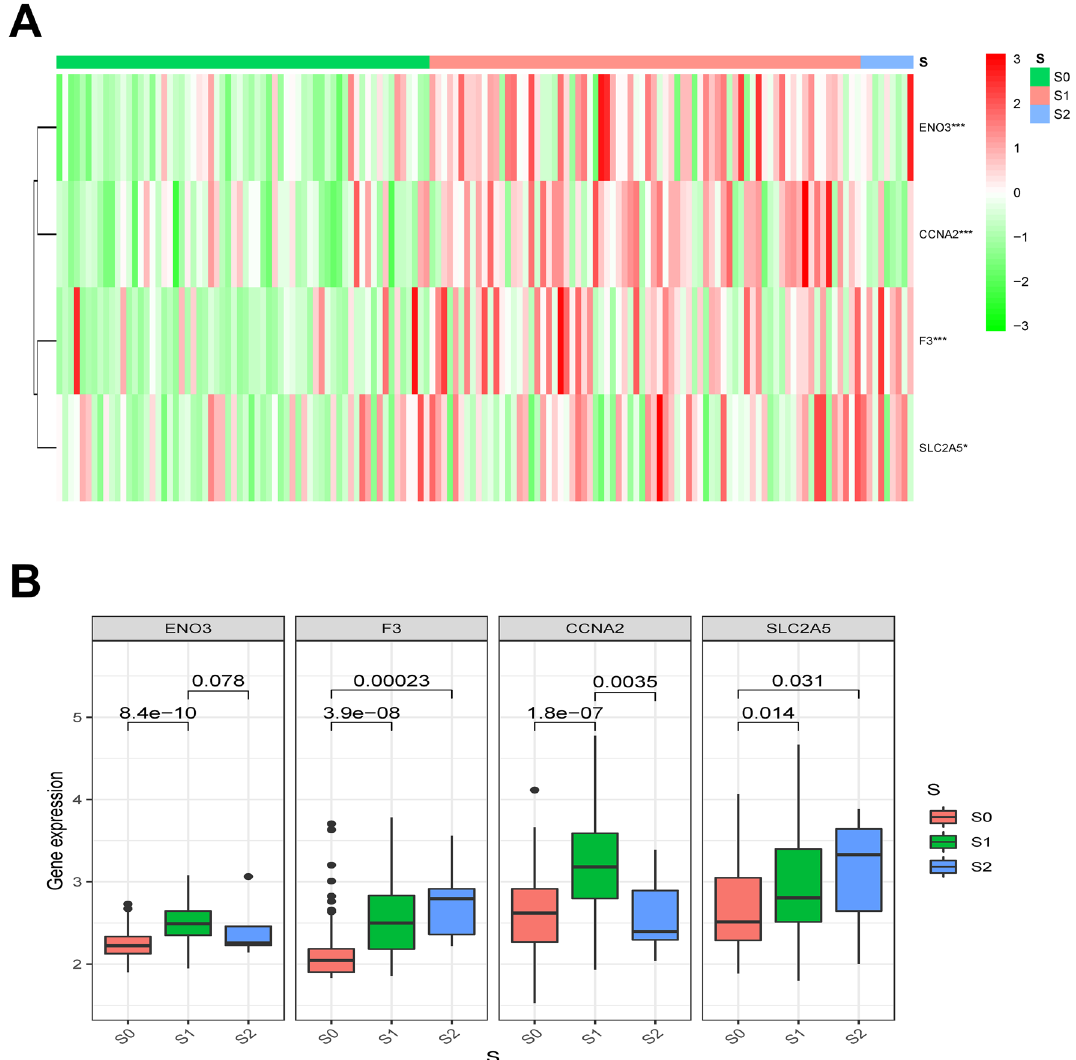
Figure 3. Relationship between hypoxia genes’ expression and clinicopathological characteristics in AML. ( A ) A heatmap showing the expression profiles of the four hypoxia-associated genes in different risk stratification from the TARGET (https:// ocg. cancer. gov/ progr ams/ target); ( B ) The four hypoxia-related genes’ expression levels in different risk stratification in childhood